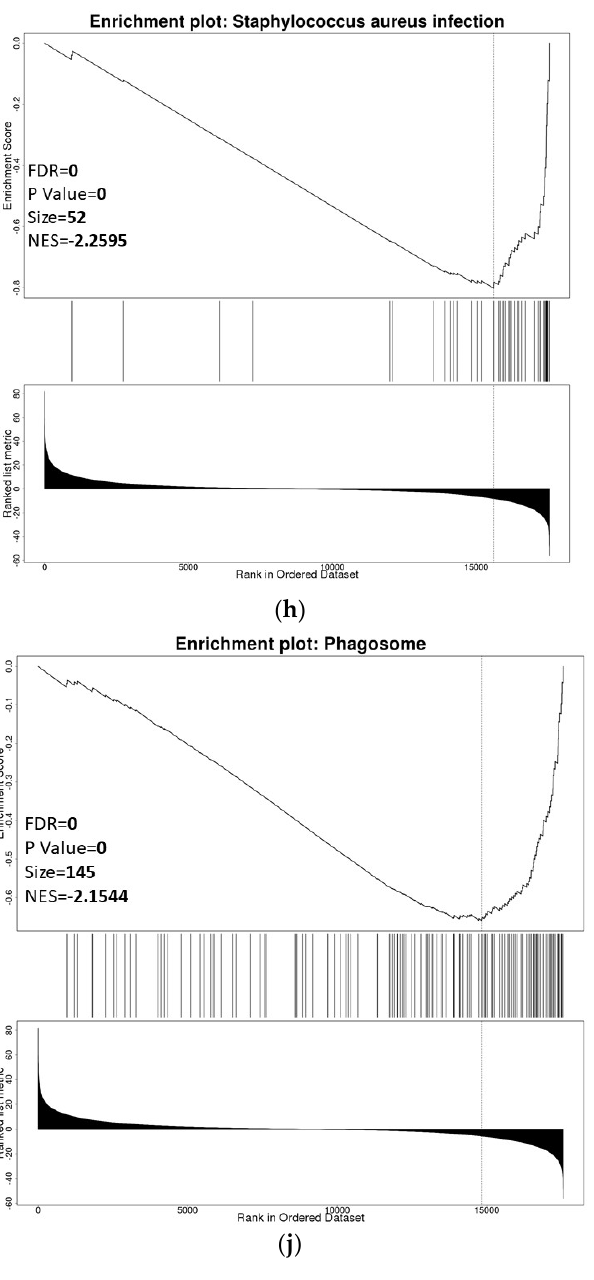
Figure 6. ( a ) Volcano plots of the negatively and positively correlated genes associated with ZNF433 expression. The green section of the volcano curve represents genes that were inversely correlated with ZNF433 expression, while the red region of the curve represents genes that were positively correlated with ZNF433. ( b ) GSEA GO Biological Process for genes co-expressed with ZNF433. Blue-colored bars represent pathways enriched in positively correlated genes, with dark blue bars representing FDR < 0.05, whereas light blue bars are pathways for which FDR > 0.05. Orange-colored bars represent pathways enriched in inversely correlated genes, with dark orange bars depicting pathways with FDR < 0.05, and light orange bars representing pathways with FDR > 0.05. ( c–f ) Enrichment plots for the top most-significant pathways that were over-represented among inversely correlated genes. ( g ) GSEA KEGG for genes co-expressed with ZNF433. ( h–k) Enrichment plots for the top most-significant pathways over-represented among inversely correlated genes in the KEGG database.